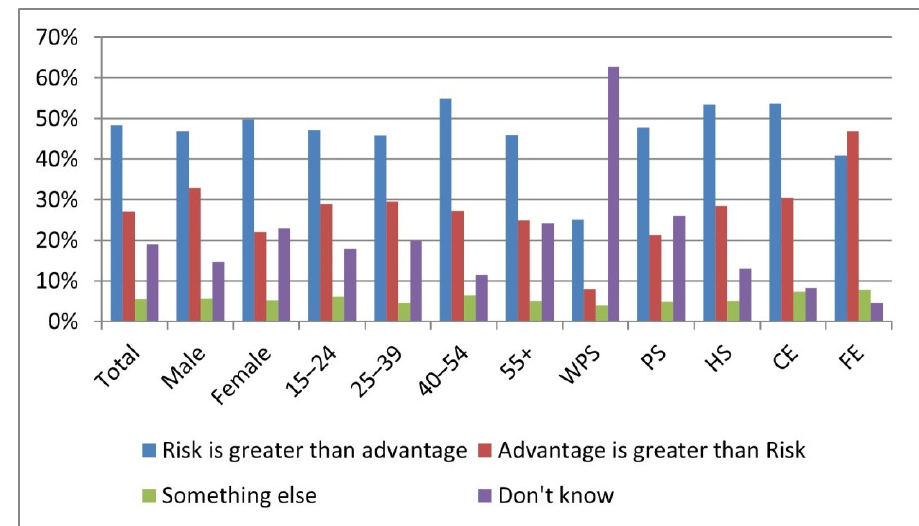
Figure 3. The nuclear power plants–a risk or an advantage (WPS–without primary school, PS–primary school, HS–high school, CE–college education, FE–faculty